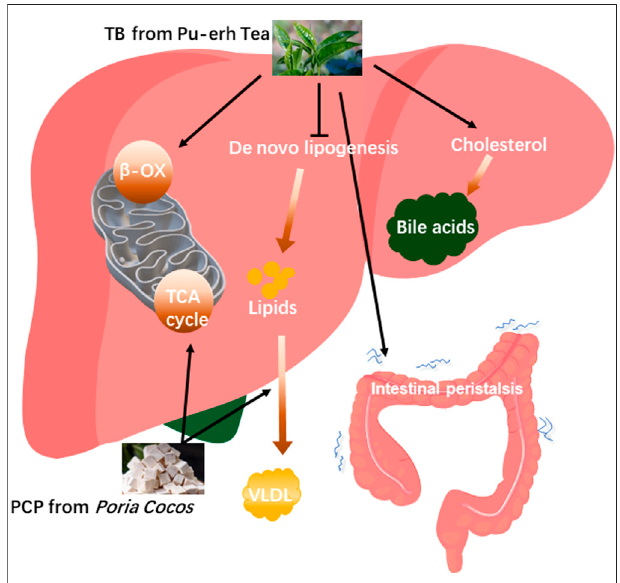
FIGURE 6 | The proposed mechanisms of theabrownin and P. cocos polysaccharide on the NAFLD